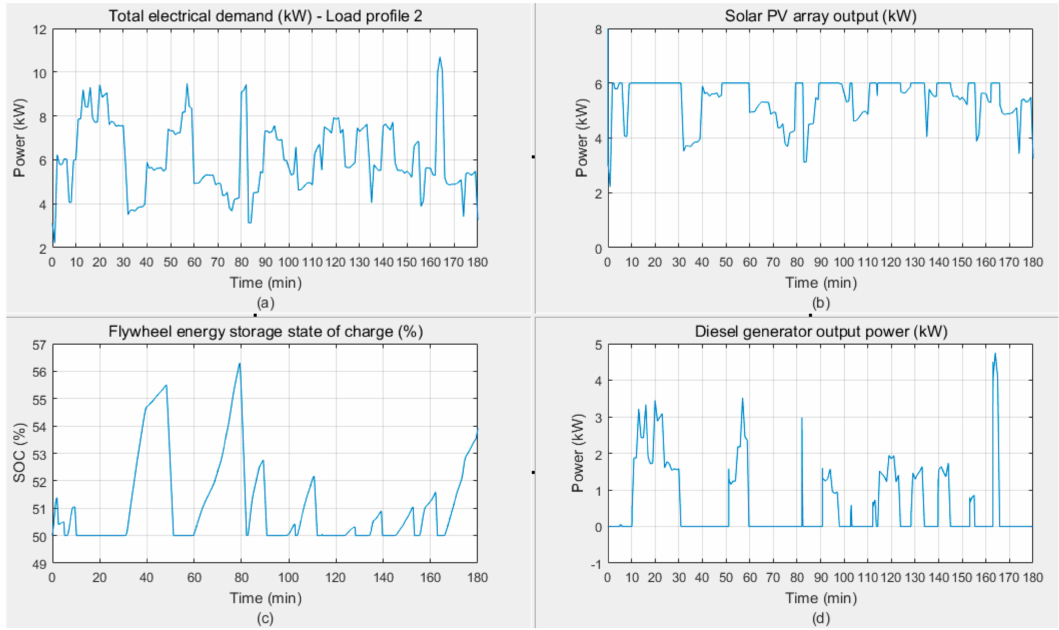
Figure 20. ( a ) Load profile 2. ( b ) PV array output power. ( c ) Flywheel initially at 50% state of charge. ( d ) Diesel generator output